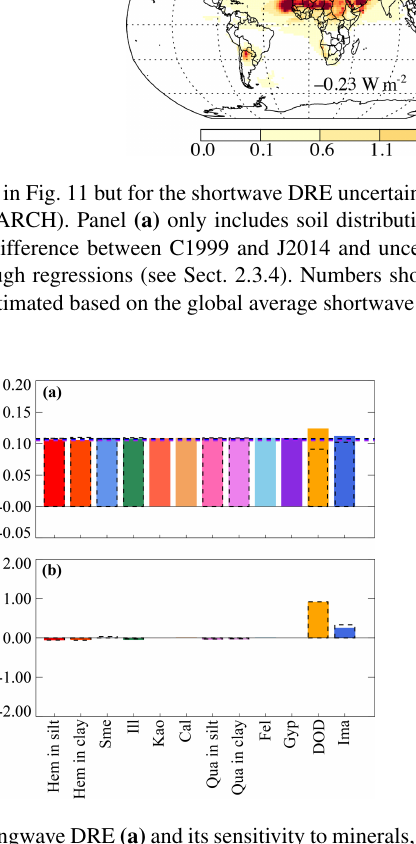
Figure 16. Longwave DRE (a) and its sensitivity to minerals, DOD, and imaginary complex refractive index (b) in CAM5. In (a) , black lines indicate values obtained from the simulation with C1999; blue lines denote values obtained from the simulation with J2014 distin- guishing hematite from goethite; purple lines are similar to blue ones but with identical optical properties between hematite and goethite. Bars: values associated with higher (in color) and lower limits (dash with opposite signs to real values) of minerals, DOD, and the imaginary complex refractive index. x -axis labels: Hem – hematite; Sme – smectite; Ill – illite; Kao – kaolinite; Cal – calcite; Qua – quartz; Fel – feldspar; Gyp – gypsum; DOD – dust aerosol optical depth; Ima – imaginary complex refractive